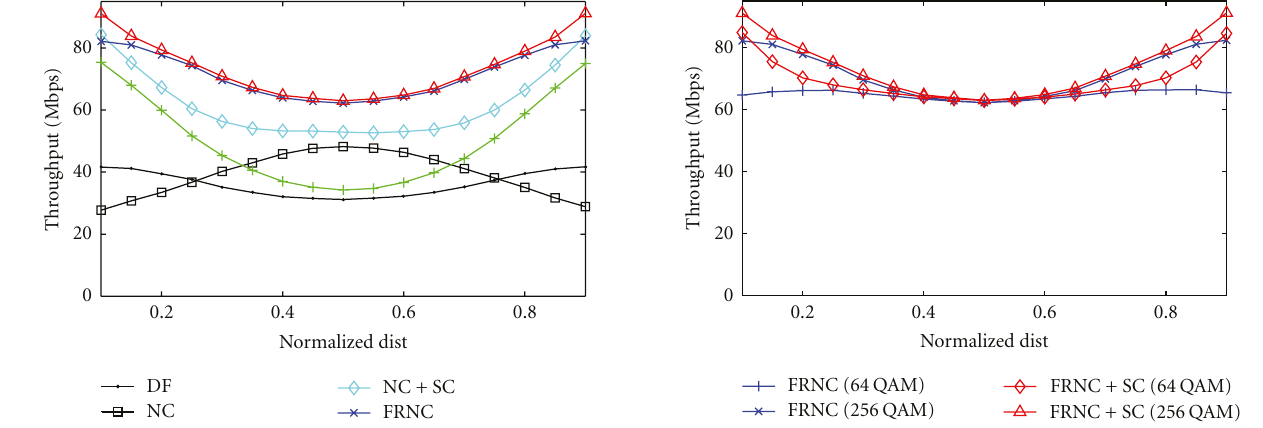
the same average SNR have di ff erent instantaneous SNR.